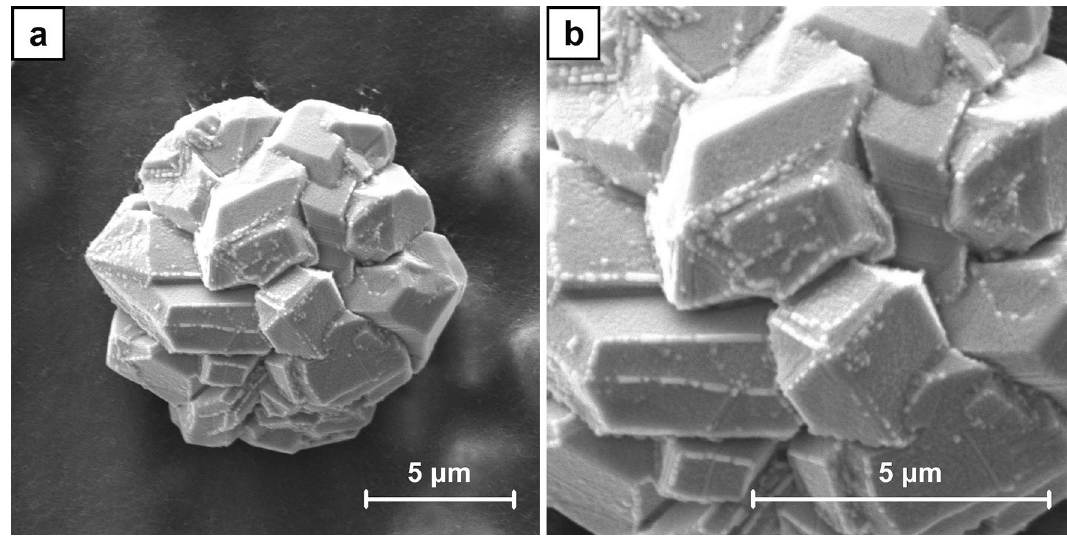
Figure 4. SEM images of the crystals agglomerate formed on CNT layer in B7 sample (ECD deposition time of 600 s, CuSO